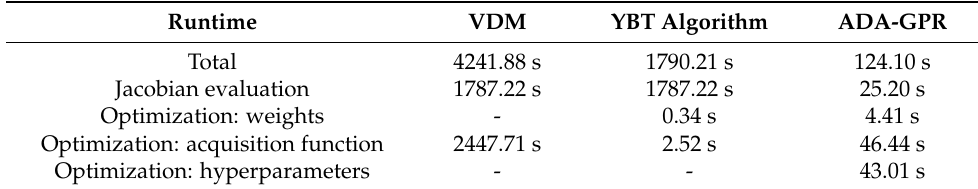
Table 5. Detailed breakdown of the runtime of all algorithms for the flash with a methanol-water input